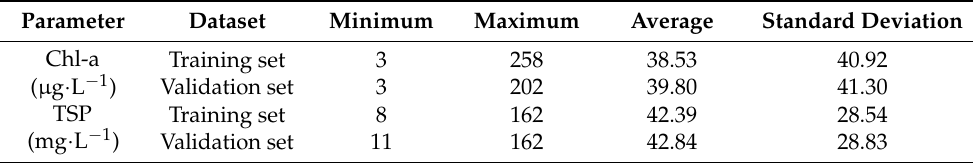
Table 3. Descriptions of the water quality